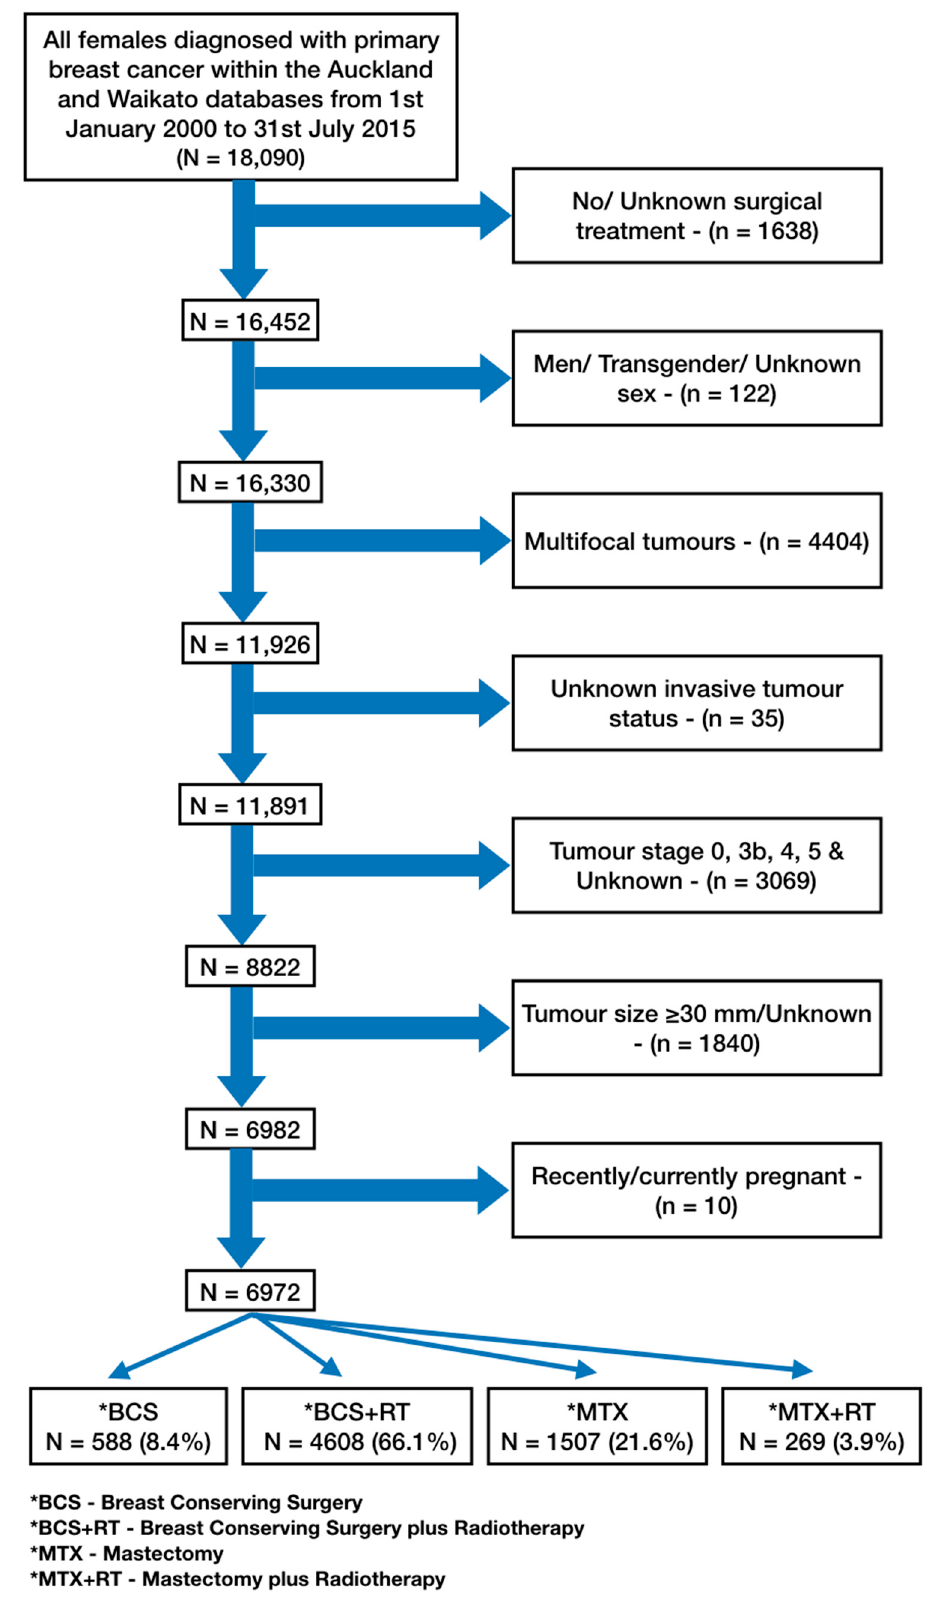
Figure 1. Sample restriction flowchart.